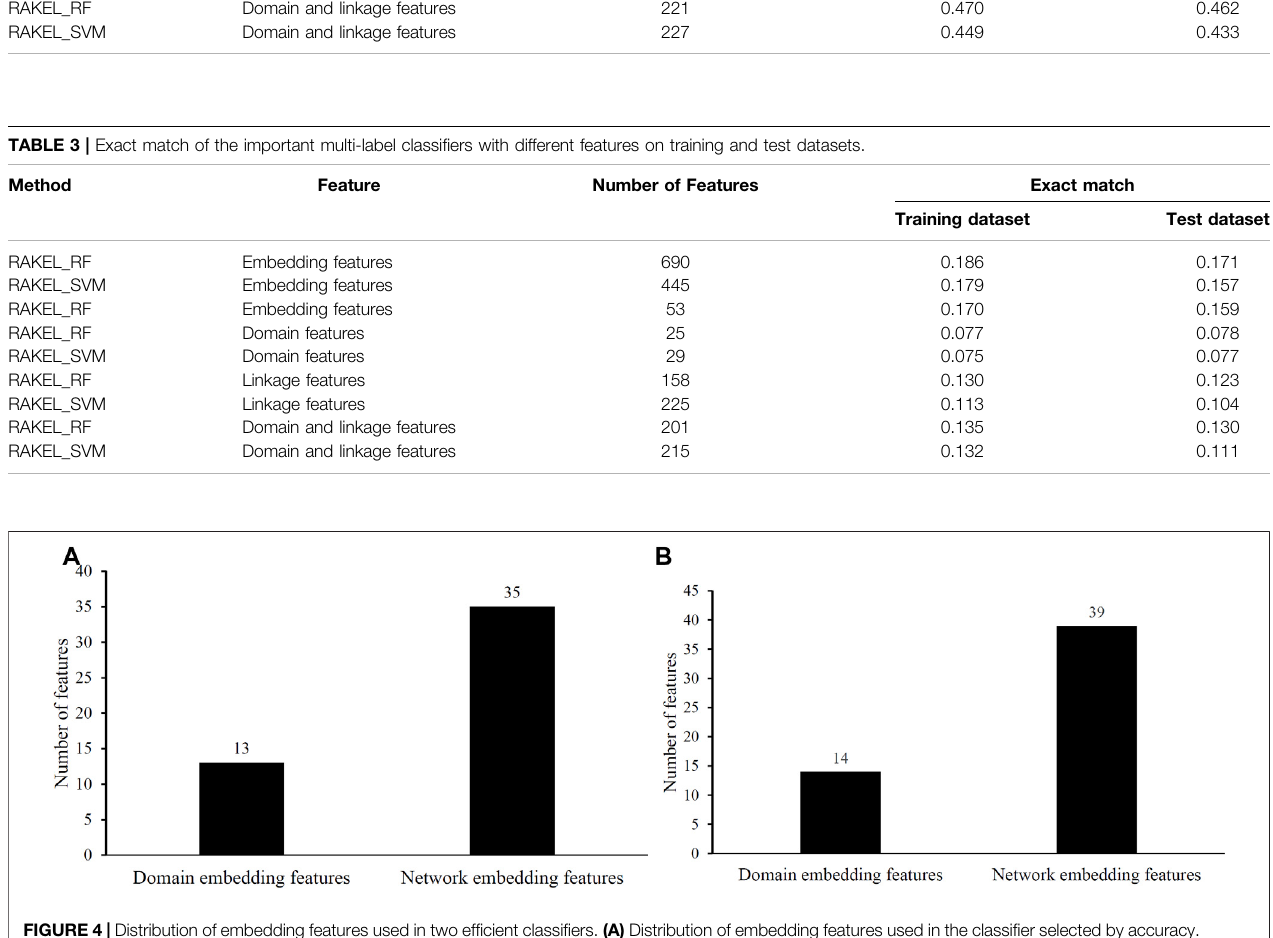
FIGURE 4 | Distribution of embedding features used in two ef fi cient classi fi ers. (A) Distribution of embedding features used in the classi fi er selected by accuracy. (B) Distribution of embedding features used in the classi fi er selected by exact